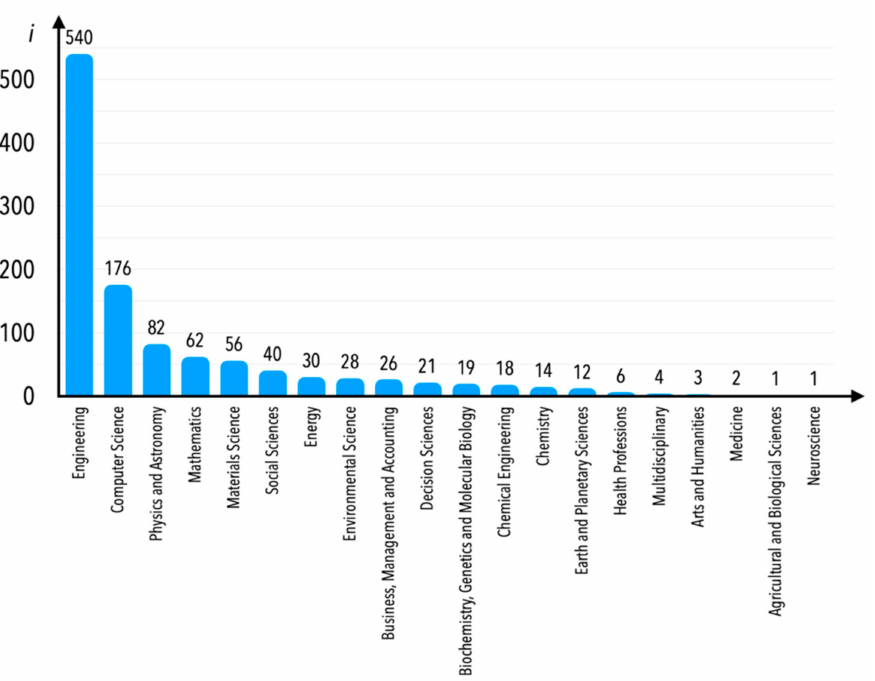
Figure 10. Number of publications ( i ) in the research area of railway transport condition monitoring per particular Scopus research area for the internal keywords “condition monitoring”.